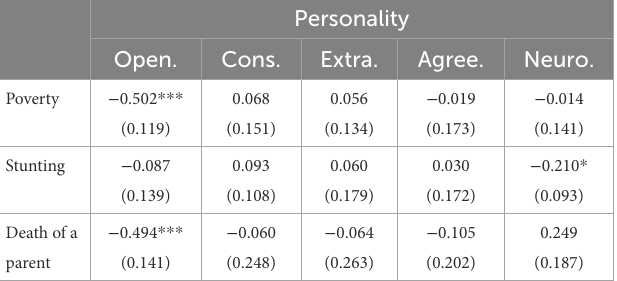
TABLE 2 Effect of childhood adversity on